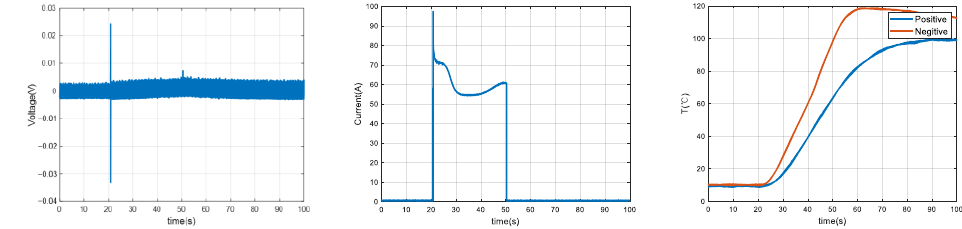
Figure 2. Voltage, current, acoustic, and temperature data curve across the entire ESC. Therefore, in terms of acoustic signal data analysis, phase spectrum analysis reduces various influencing factors to obtain signal amplitude and phase values for further research. The frequency-domain characteristics of the AE signal were analyzed from the time-domain acoustic signal by Fast Fourier Transform